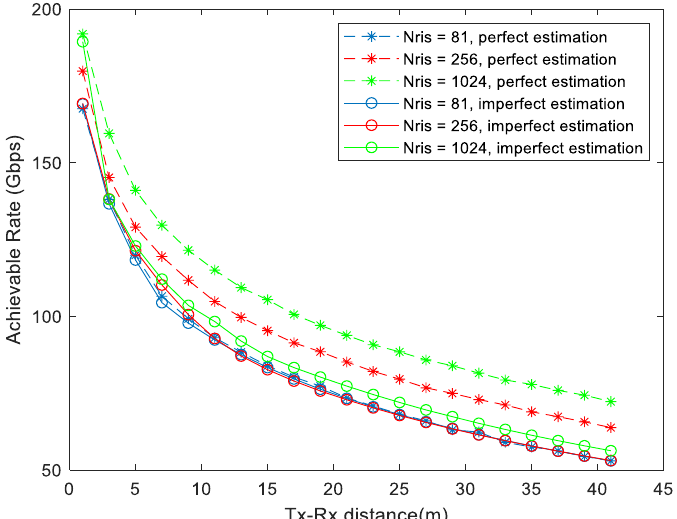
Figure 7. Achievable rate of the proposed APG for the case of perfect/imperfect estimation versus distance between BS – User, considering N s = 1, N tx = 256 and N rx = 4.